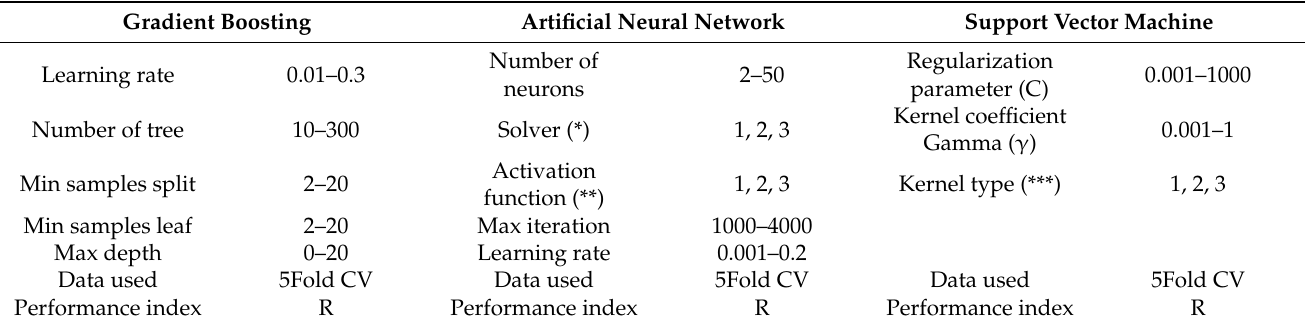
Table 2. Hyper-parameters space of machine learning (ML)